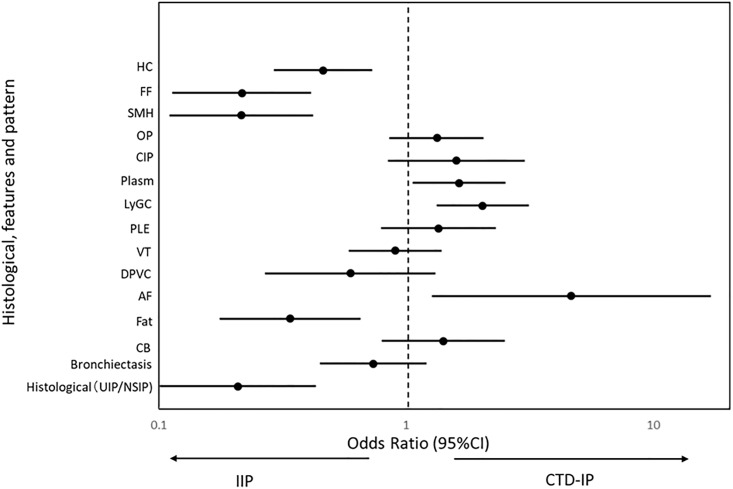
Odds ratio comparing connective tissue disease associated interstitial pneumonia and idiopathic interstitial pneumonia.Eight out of 14 scored histological findings along with histological diagnosis of usual interstitial pneumonia (UIP) versus nonspecific interstitial pneumonia (NSIP) are identified by simple Logistic regression to separate idiopathic interstitial pneumonia (IIP) and connective tissue disease associated interstitial pneumonia (CTD-IP).